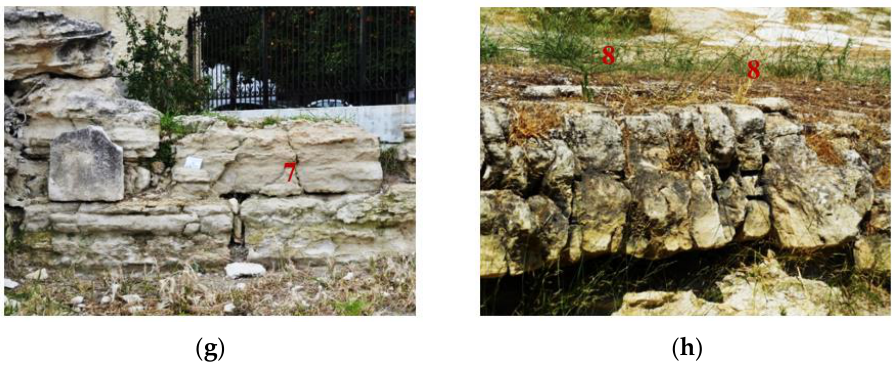
Figure 3. In situ identification of weathering phenomena: (i) sea-salt deposits and crusts ( a ), efflorescence and sub-fluorescence ( b ); (ii) differential erosion ( c ) and alveolization (honeycombs) ( d ); (iii) exfoliations ( e ), cracks induced from clay swelling ( f ), spalling and splitting ( g ); and (iv) biological and colonization ( h ).